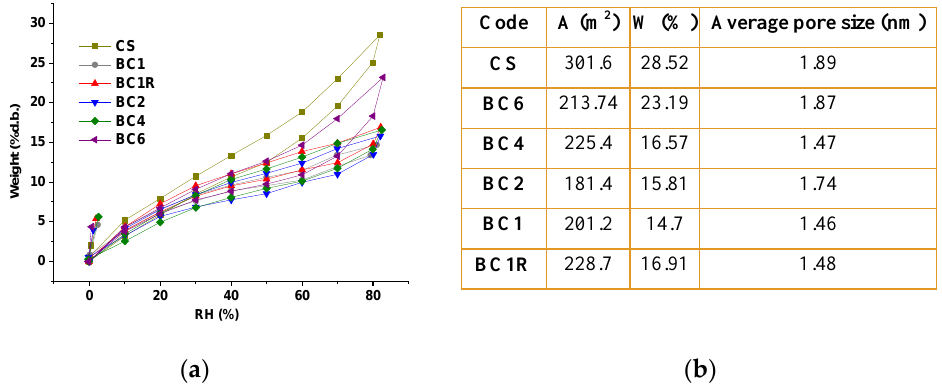
Figure 5. ( a ) Water vapor sorption isotherms of fiber mats; ( b ) Parameters of the water sorption of studied samples (A = BET surface area; W = maximum water uptake).